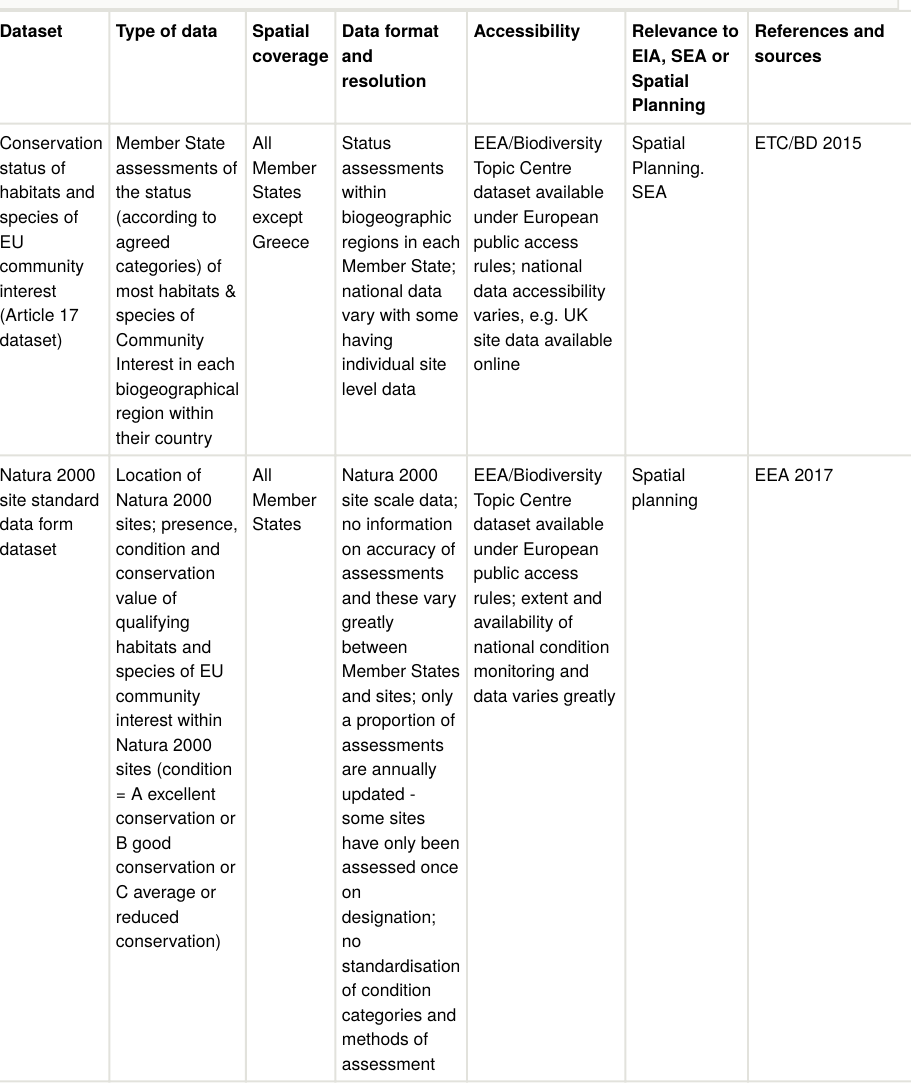
Table 3. Terrestrial biodiversity data sets and related environmental data sets at the EU level (see Suppl. material 1 for further information and links